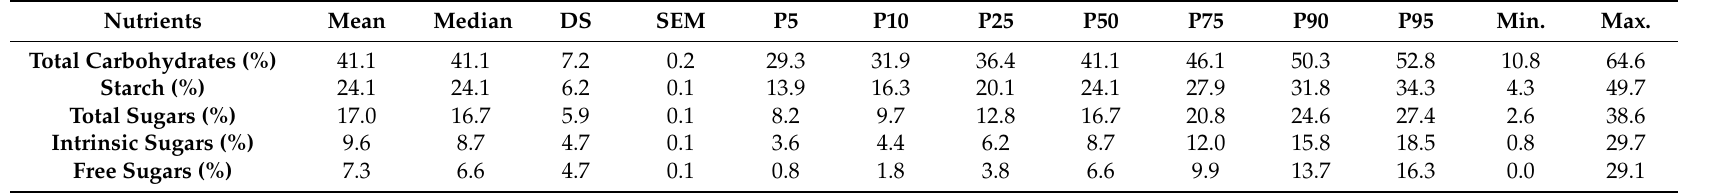
Table 2. Carbohydrates distribution (% of total energy) in the Spanish ANIBES Study population (9 to 75 years old).